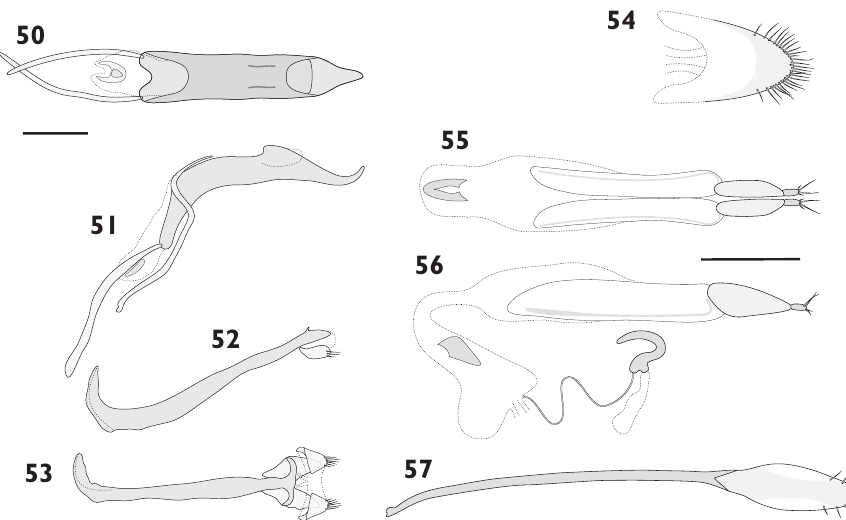
Figures 50–57. Genitalia of Austromonticola furcatus . 50 penis, dorsal view 51 aedeagus, lateral view 52 male hemisternites 8 and spiculum gastrale, lateral view (membrane between hemisternites 8 and basal plate indicated) 53 male hemisternites 8 and spiculum gastrale with basal plate, ventral view 54 female tergite 8, dorsal view 55 ovipositor, dorsal view 56 ovipositor and spermatheca, lateral view 57 female sternite 8, ventral view. Scale bars = 0.5 mm; 50–53 at same scale; 54–57 at same scale.